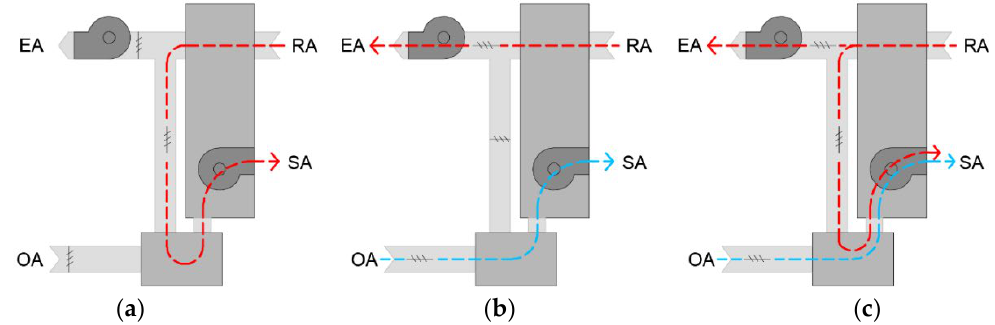
Figure 3. Operating method of the cooling system for the computer room: ( a ) All-air recirculation; ( b ) outdoor air cooling; ( c ) mixed type.